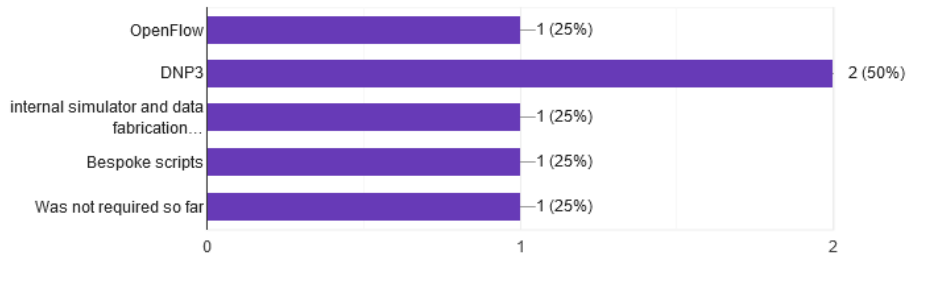
Figure 15. Network